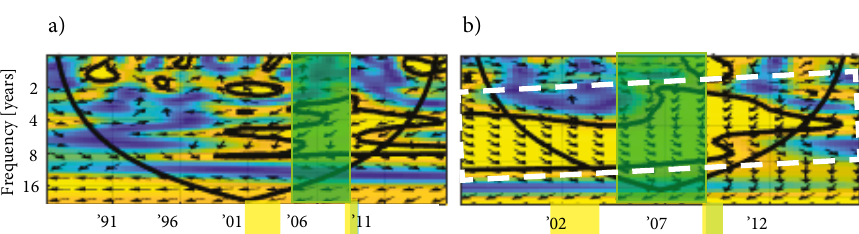
Figure 2. Wavelet coherence between: a – M3 and stock prices; b – bank credit and stock prices for Japan (source: own work)